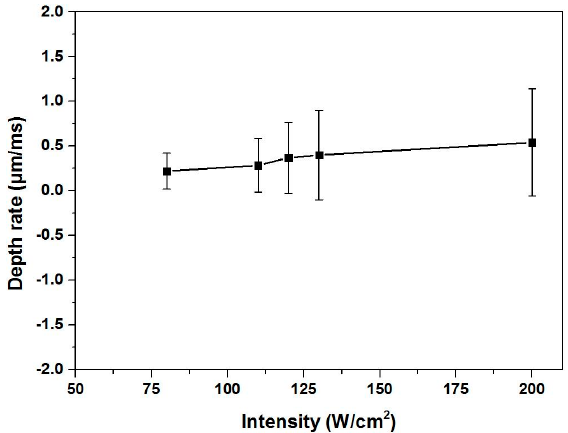
Figure 3. The relationship between the removal depth rate and the intensity for epoxy polyester (EP) coatings.